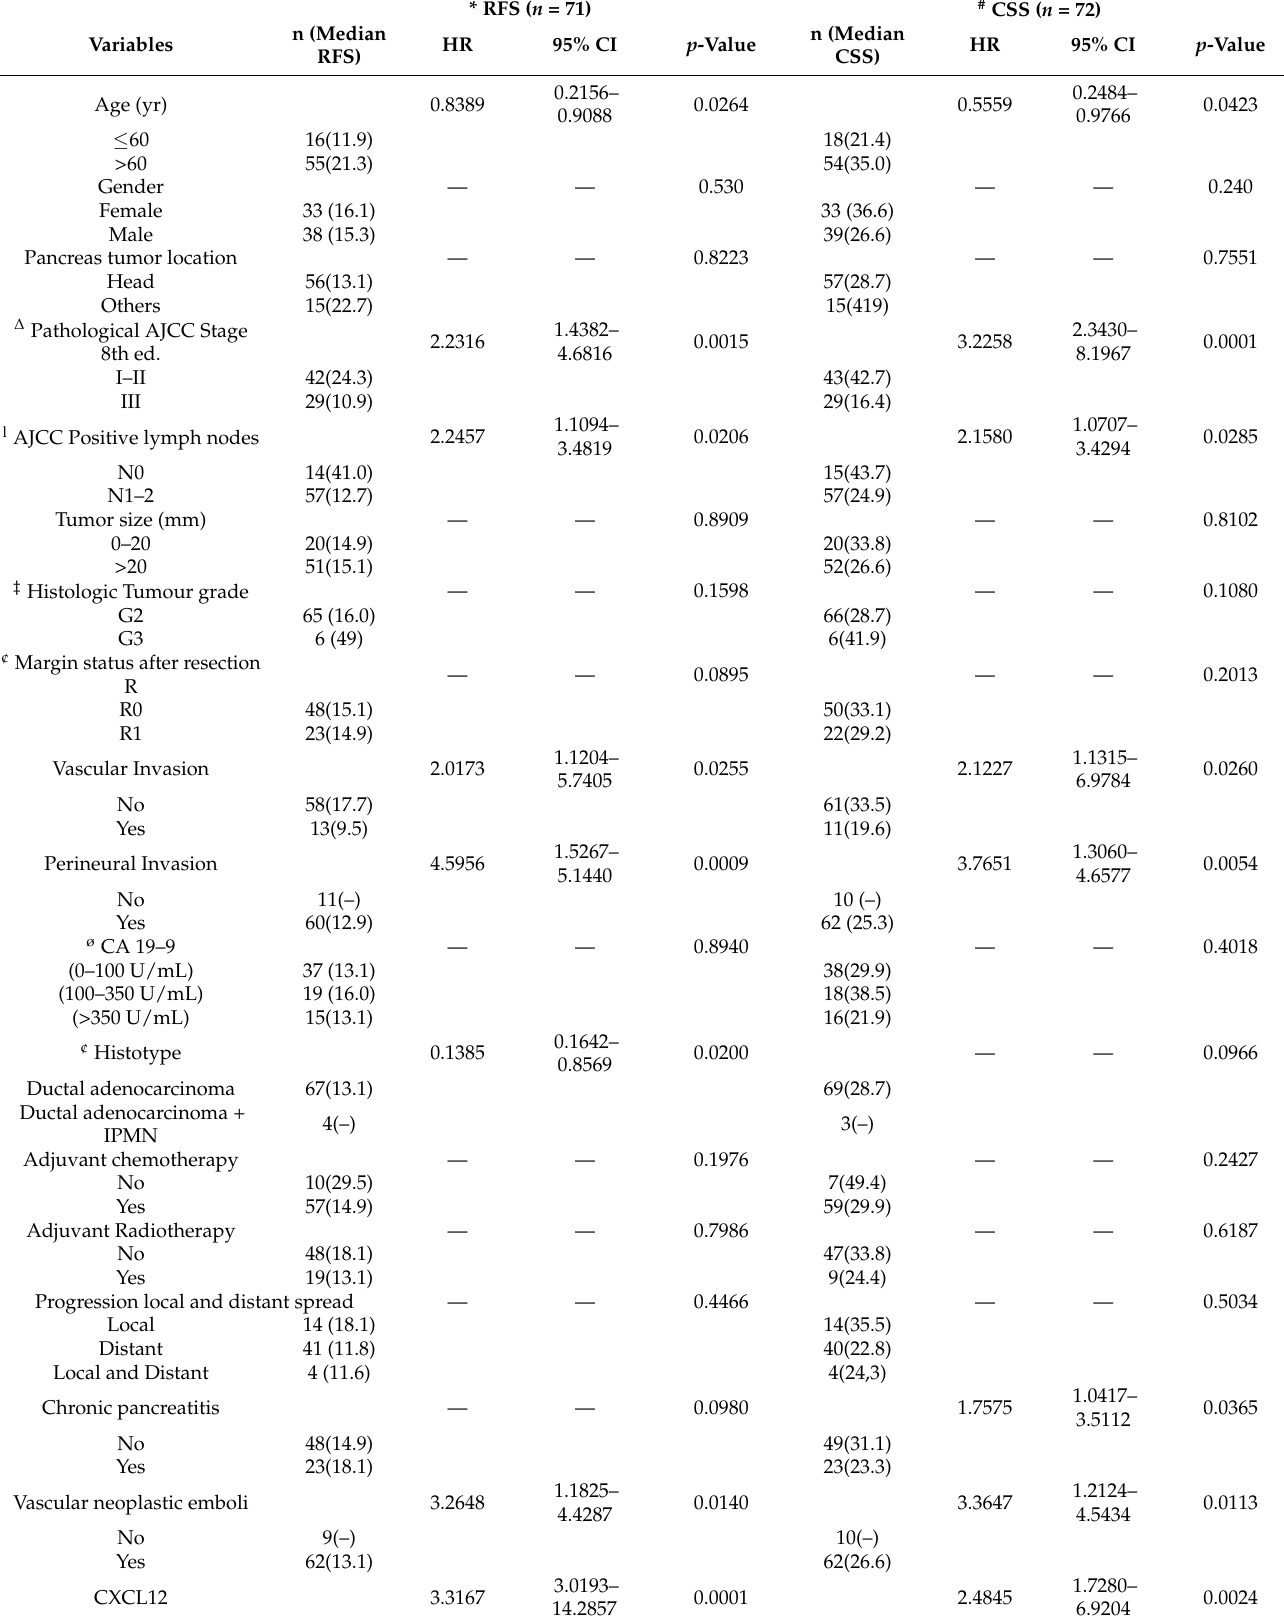
Table 4. Univariate analysis of cancer specific survival and recurrence-free survival: Log rank